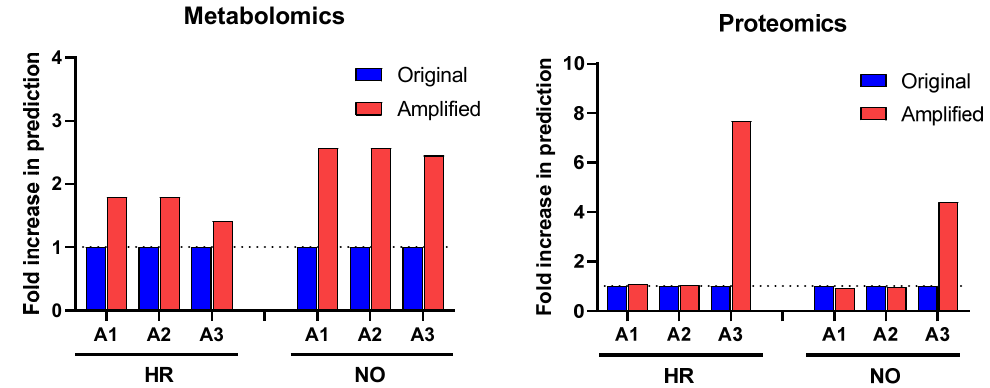
Figure 2. Change in prediction yields of canonical pathways identified in the amplified (A1, A2, and A3) vs. original proteomics and metabolomics datasets by IPA based on published literature available in its knowledge-database as of the time of performing the analysis (https://go.qiagen.com/IPA-transcriptomics-whitepaper, accessed on 27 August 2022). Numbers of canonical pathways predicted in the amplified datasets (red) are shown as fold-change (increase above dotted line) in comparison to the original datasets (blue) for the high-risk (HR) and new-onset (NO) subject groups. Comprehensive lists of these canonical pathways are presented in Supplementary Table S1A,B (for metabolomics) and Supplementary Table S2A,B (for proteomics) in HR and NO subject groups. Table 1. Selected canonical pathways identified/predicted in the original and amplified proteomics and metabolomics datasets for the HR and NO subject groups. Selection was based on involvement in inflammatory processes, such as cytokine and chemokine signaling and immune cell functions, and subsequent validation in published literature with direct relevance to T1D. Shown are the values of − log( p ) for each identified/predicted canonical pathway in each dataset, and only those with at least one significant prediction (i.e., − log( p ) > 1.3 or p < 0.05) are shown. When significance was reached in one of the datasets (original or amplified), parallel non-significant predictions with − log( p ) values < 1.3 are shown in gray color to highlight differences. Blank means no